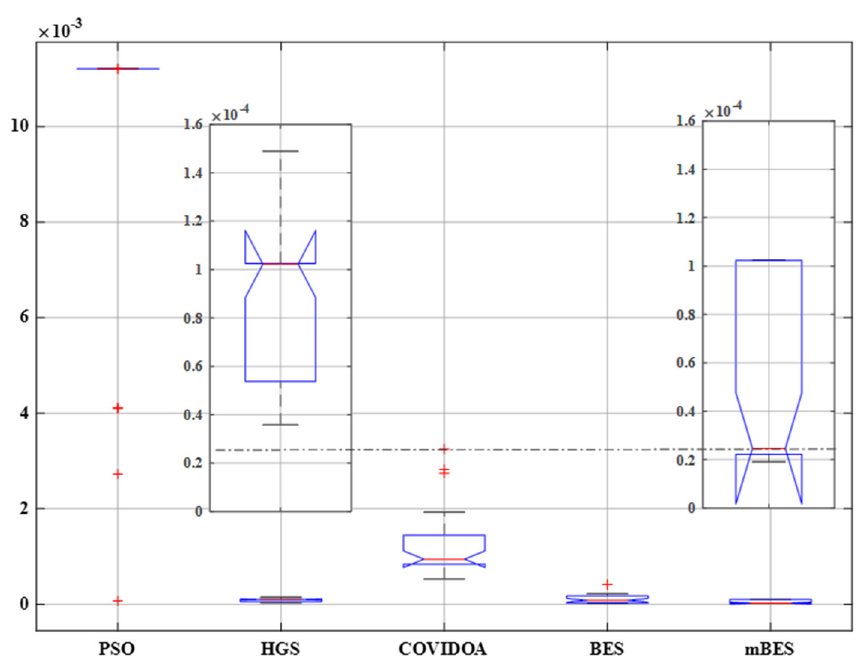
Figure 7. Tukey ranking for control.